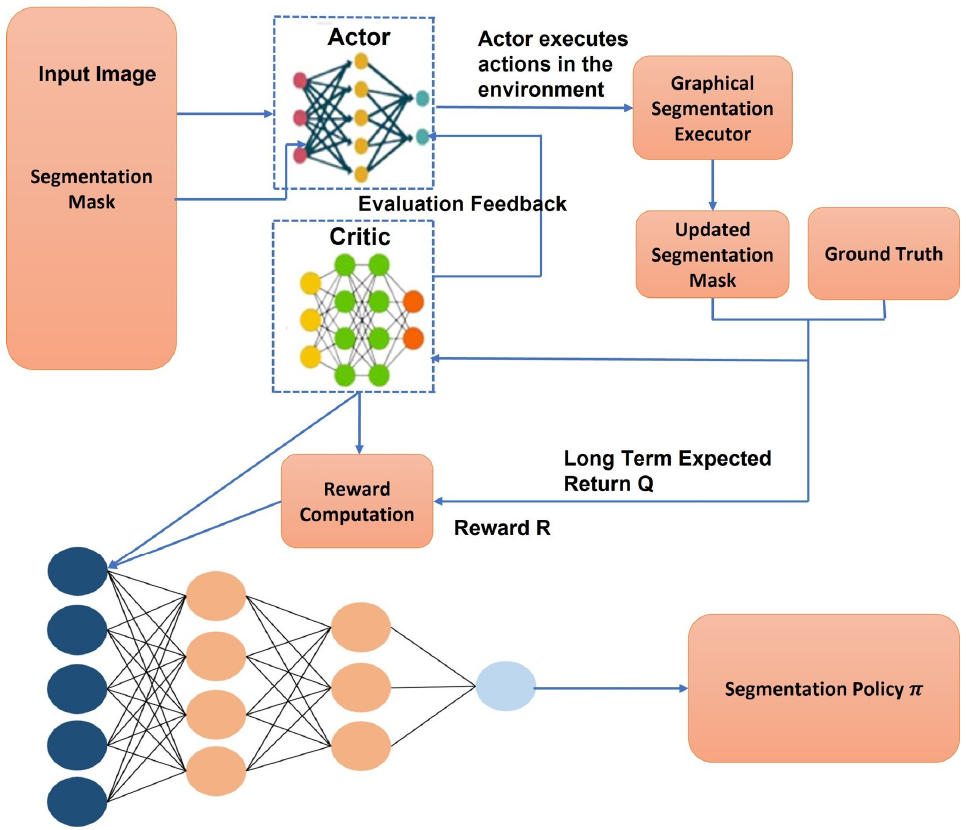
Figure 4. Our RL framework for the segmentation process. The set of actions selected by the actor depend on the new segmentation mask S mt and the input image. The parameters are passed to the segmentation executor. S mt + 1 , the updated segmentation mask, is then produced by the segmentation executor. The new segmentation mask has three distinct features. The mask is used for the calculation of reward by comparison with the ground truth mask. Secondly, it is given as input to the critics and the ground truth to calculate the Q’s long-term estimated return. Thirdly, it is used for updating the previously used S mt segmentation mask. The critic actor and segmentation executor are both built using neural networks. The current segmentation methodology π is evaluated by the evaluator and is based on the long-term return Q and reward R.